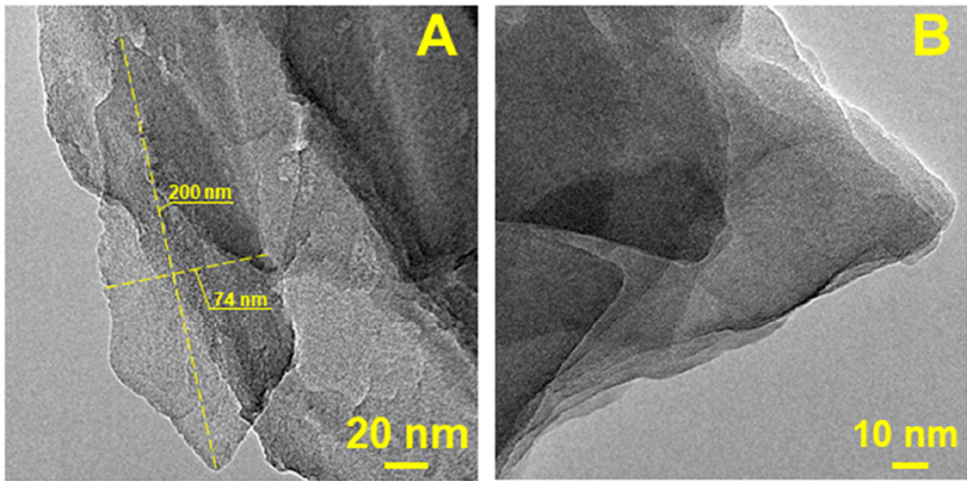
Figure 3. TEM images of Clin at two different magnifications, ( A ) 20 nm and ( B ) 10 nm.